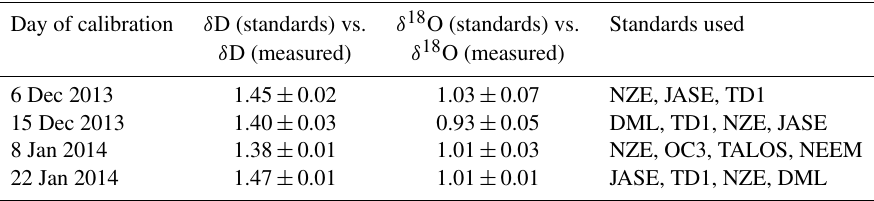
Table 1. Conversion slopes calculated from four VSMOW–SLAP calibrations with different standards. Data have been corrected with respect to humidity before calculating the slopes. Uncertainties represent 1SE (standard error) on the